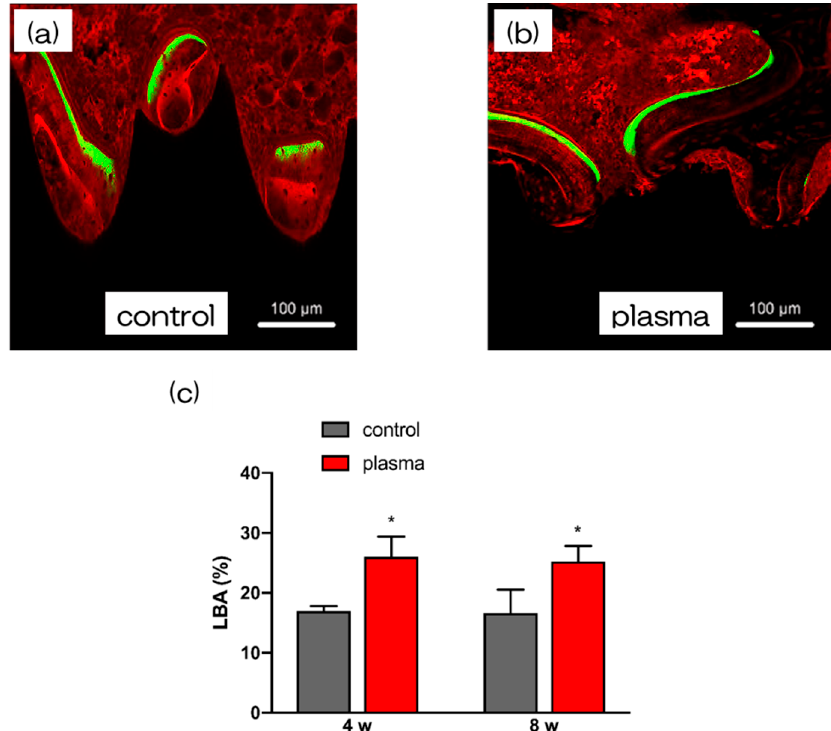
Figure 7. The sequential fluorescent labeling was also performed by scanning microscopy to analysis the process of bone formation. ( c ) The test implants showed increased fluorescent areas than control implants, indicating that alkali-plasma treatment might endow titanium with better bone deposition and remodeling at each time point. (* p < 0.05). It is clear from ( a , b ) that the dyes of the two colors of 4w and 8w were dyed, although the dyes of three colors were used in this experiment. However, when both stained images were confirmed, it was clear that the amount of new bone formation in group b was high in ( a , b